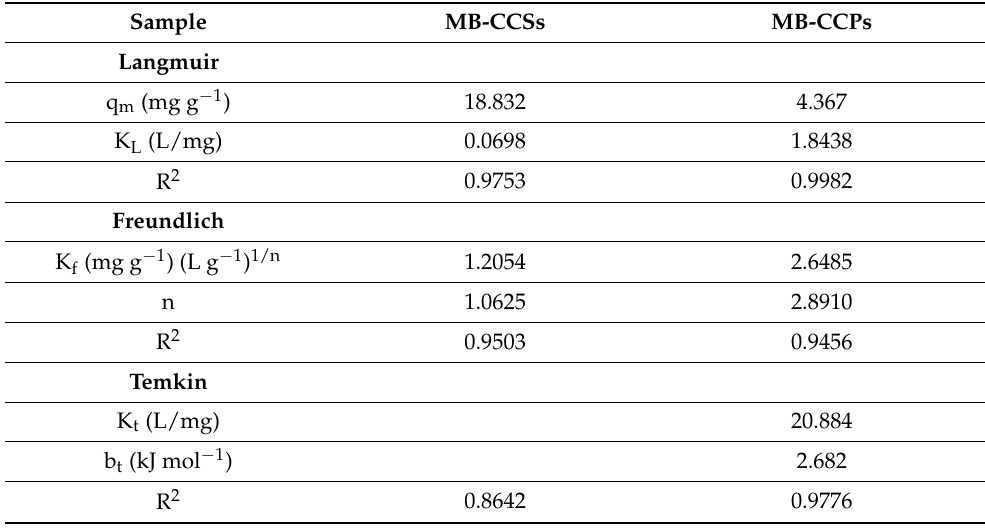
Table 3. Different parameters of isotherm models for MB adsorption onto CCSs and CCPs. Sample